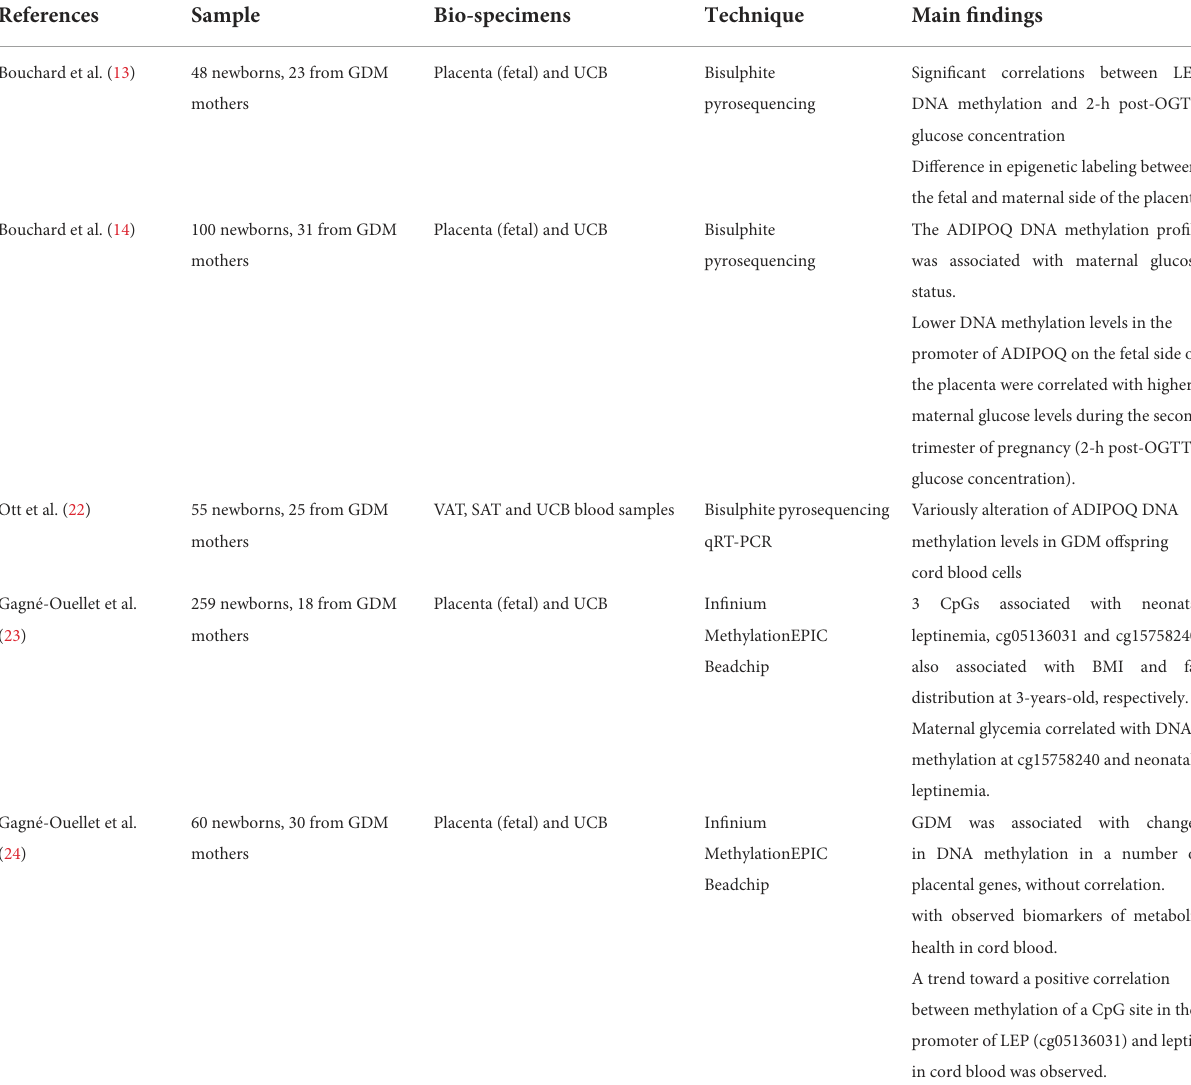
TABLE 1 Human studies investigating epigenetic alteration of LEP and